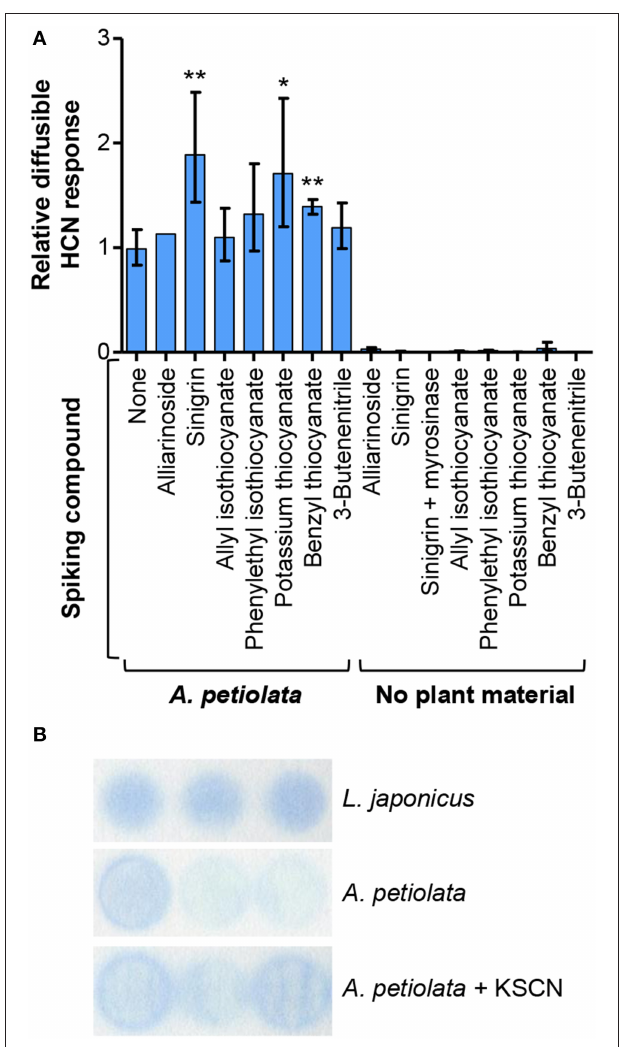
FIGURE 7 | The diffusible HCN response from sinigrin and organic/inorganic thiocyanate is dependent on the presence of A. petiolata enzymes. (A) Colorimetric HCN detection based on the König reaction was used to quantify the diffusible HCN response in homogenates of A. petiolata leaves. The effect of spiking the homogenate with alliarinoside (14), sinigrin (15) or available glucosinolate degradation products was quantified relative to the untreated samples ( n = 4 , except alliarinoside: n = 2 ). The relative diffusible response was significantly increased by addition of sinigrin, benzyl thiocyanate ( ** P < 0.01 ) or KSCN ( * P < 0.05 ), whereas other compounds had no significant effect (one-tailed unpaired t -test of log 10 -transformed ratios). The back-transformed mean ± SD is depicted. (B) Feigl-Anger paper, a different colorimetric method for HCN detection, was used to confirm the effect of KSCN on the diffusible response from leaf homogenates of A. petiolata . Results of triplicates are shown. As positive control, highly cyanogenic Lotus japonicus leaf material was used (4mg FW sample − 1 ). Larger amounts of leaf material were applied to obtain a detectable response from A. petiolata (60mg FW sample − 1 ). There was a tendency to more intense color development in A. petiolata samples added KSCN.